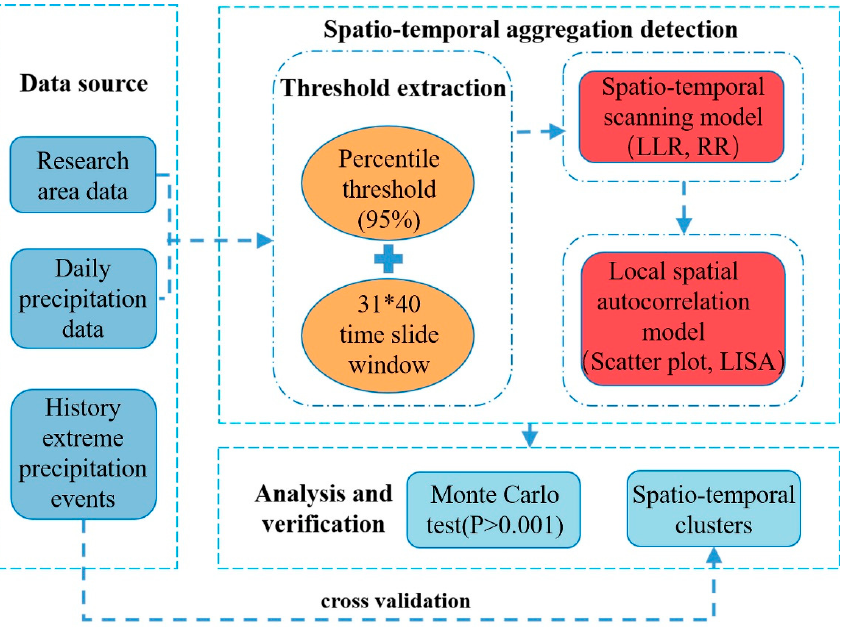
Figure 2. Spatio-temporal aggregation detection flow chart for extreme precipitation. LLR: log likelihood ratio; RR: relative risk; LISA: local indicators of spatial association. likelihood ratio; RR: relative risk; LISA: local indicators of spatial